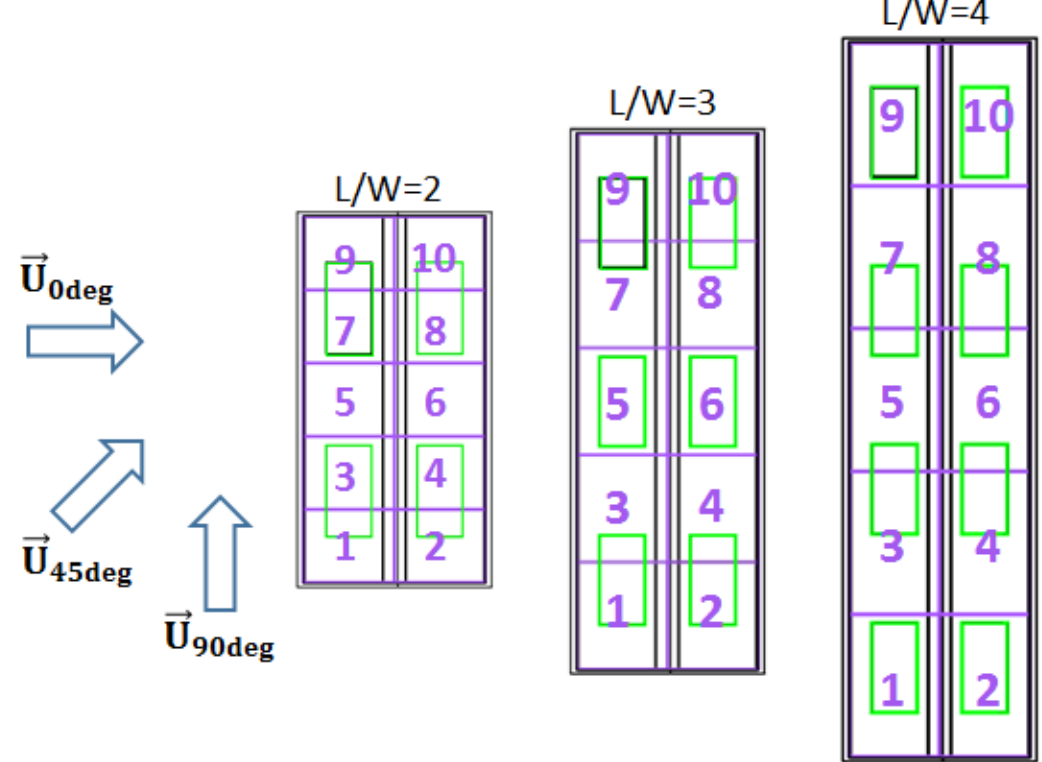
Figure 5. Local AER volume subdivisions for the different L / W ratios, 10 boxes subdivision in red, with their corresponding number in violet.